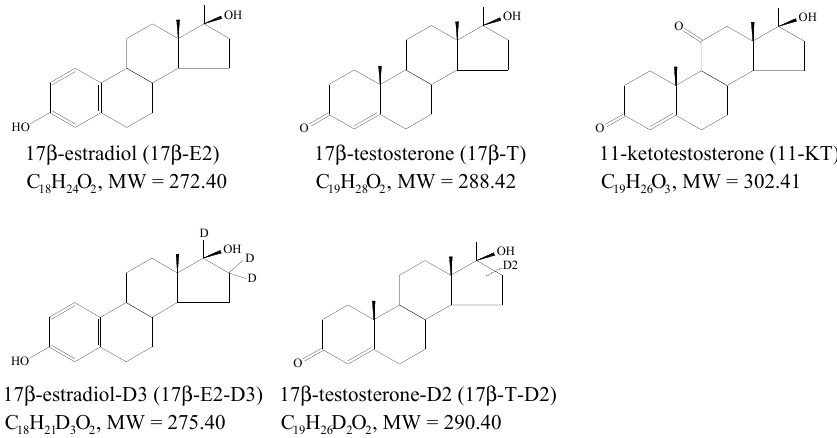
Figure 1. Chemical structures, molecular formulas and weights of the compounds tested.